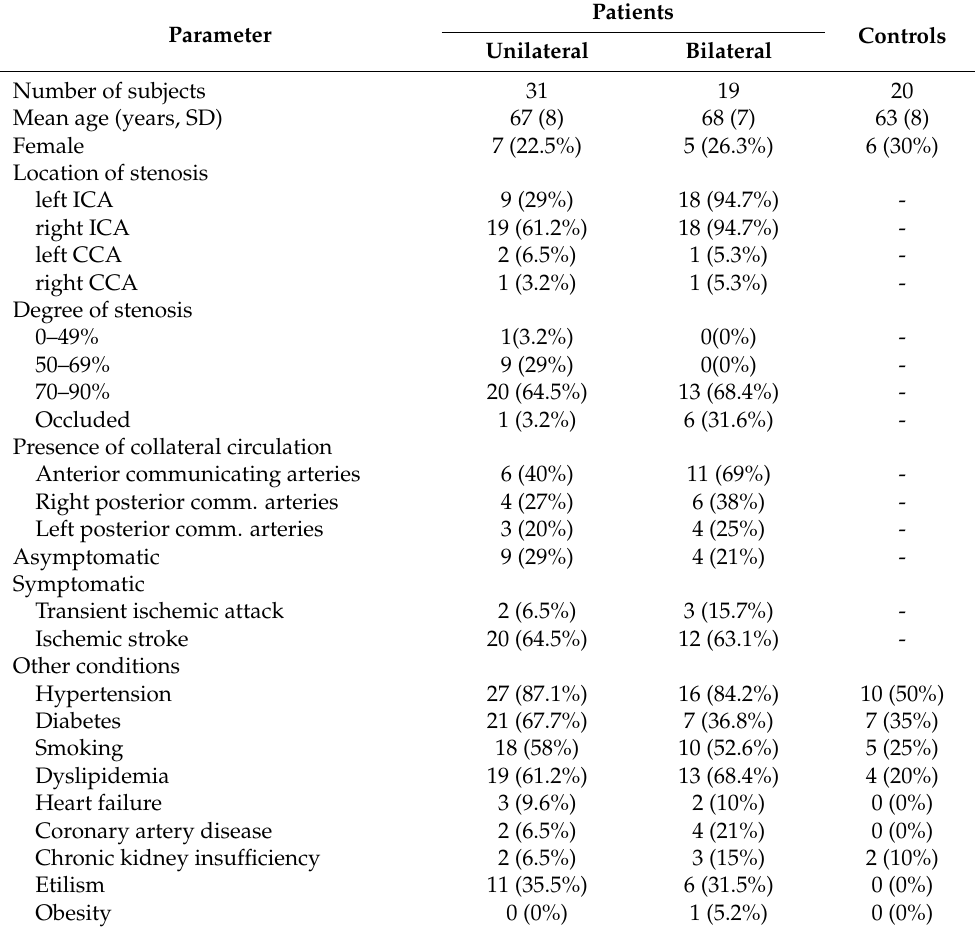
Table 1. Demographic and clinical characteristics of the study population. SD: standard deviation, ICA: Internal carotid artery, CCA: Common carotid artery. Data are given as the number of subjects and percentage (i.e., n (%)) of the total included subjects within each group, except when indicated in the first